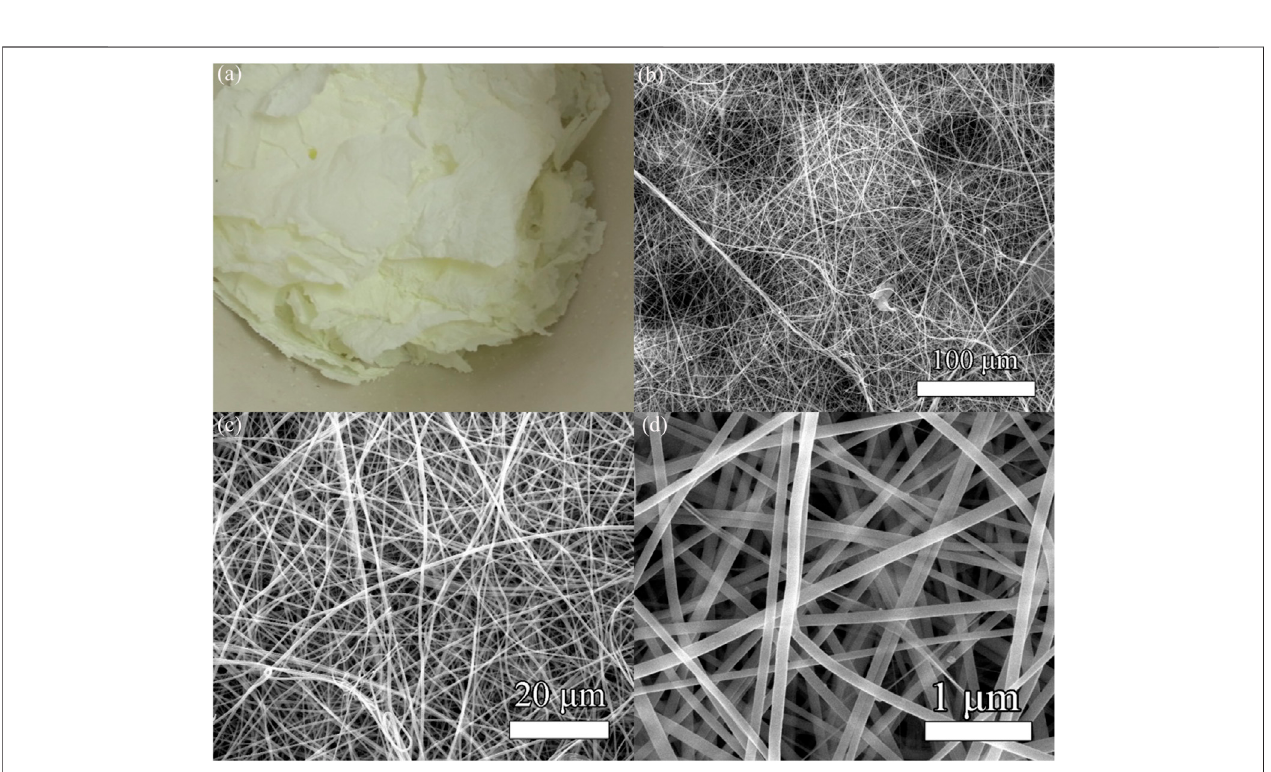
FIGURE 3 | (A) Real photographs of CeO 2 nano fi ber membranes. (B – D) SEM images of CeO 2 nano fi ber membranes at different magni fi cations.